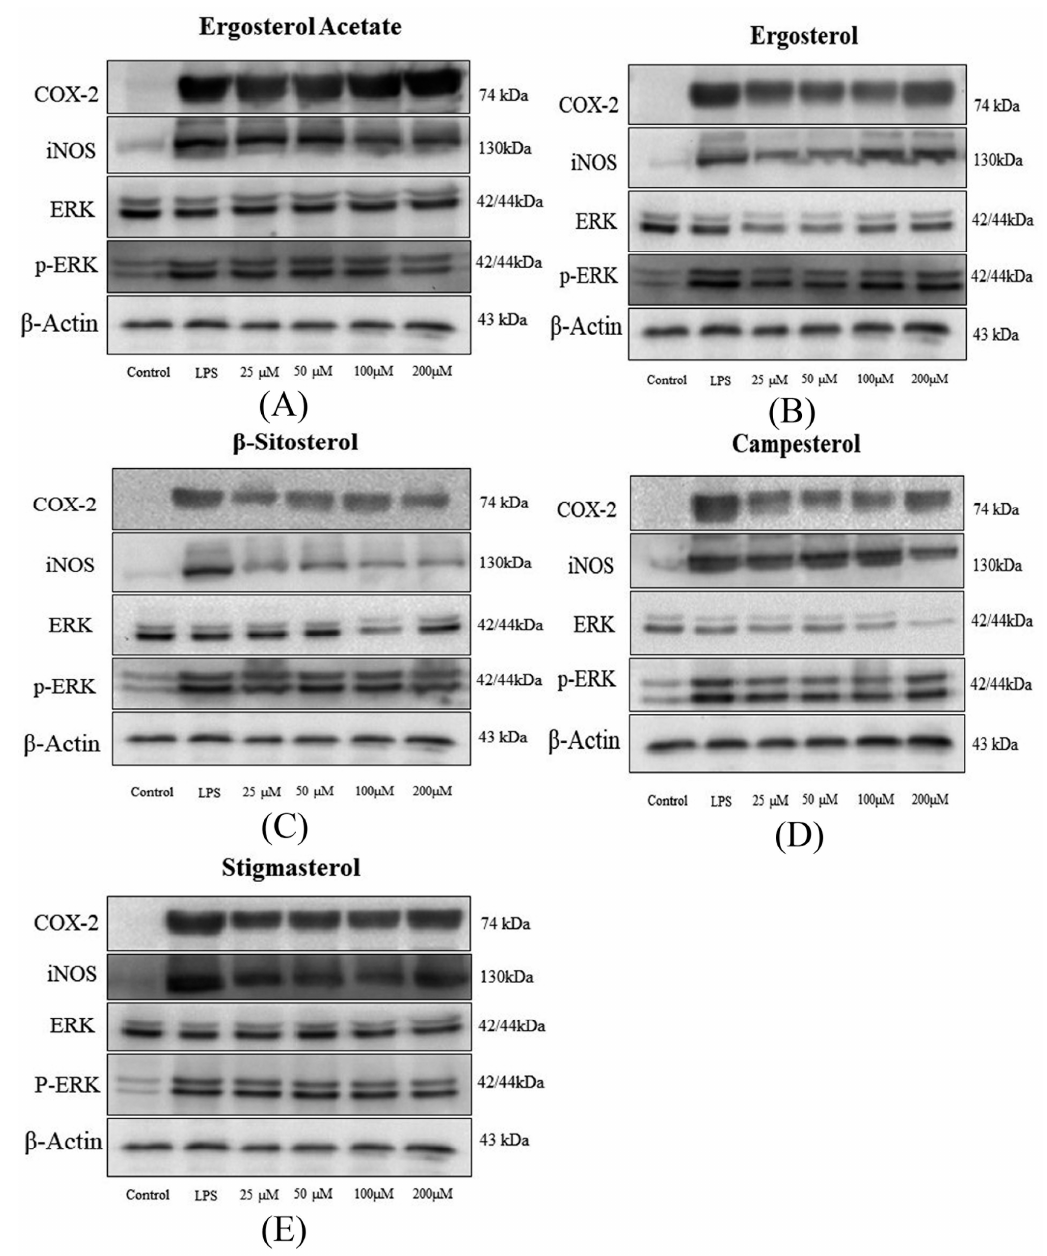
Figure 5. Results of Western blot for the expression of inflammatory regulators (cyclooxygenase-2 (COX-2), inducible nitric oxide synthase (iNOS), extracellular signal-regulated protein kinase (ERK), phosphorylated ERK (p-ERK), and β -actin): ( A ) ergosterol acetate; ( B ) ergosterol; ( C ) β -sitosterol; ( D ) campesterol; ( E ) stigmasterol.